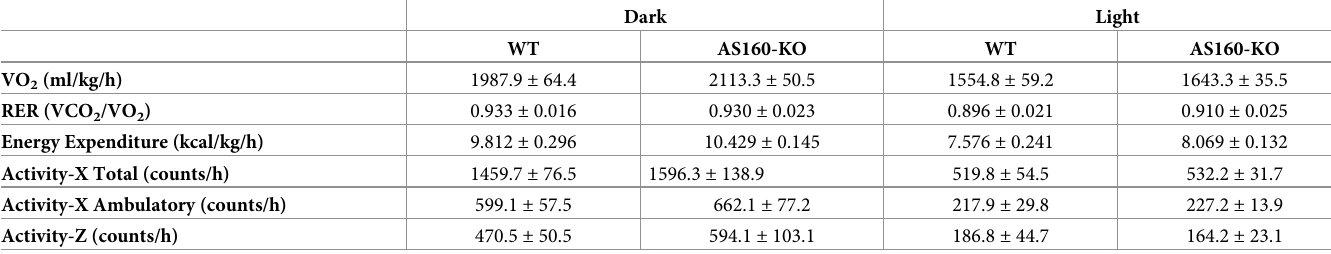
Although 6 WT and 6 AS160-KO rats underwent an HEC, 2 rats from each genotype were not successfully clamped because of technical problems. A catheter placed in one AS160-KO rat failed during the HEC, and the coefficient of variation (CV) for glycemia exceeded 20% for three rats (WT, n = 2; AS160-KO n = 1). Accordingly, the data from these 4 rats were not included in the statistical analysis of parameters dependent on blood glucose or insulin (Table 4), tissue glucose uptake and phosphorylated insulin signaling proteins. The CV for the remaining 4 WT rats (3–14%) was comparable to the CV for the remaining 4 AS160-KO rats (5–12%), and the reported values for blood or plasma parameters, tissue glucose uptake, and phosphorylated signaling proteins from the HEC experiment represent the data collected from these 8 animals. Because the total abundance of proteins (AS160, TBC1D1, GLUT4, GLUT1 and hexokinase II) would not be responsive to brief changes in glucose or insulin levels, these values are expressed for all of the rats undergoing the HEC (n = 6 of each genotype). No Table 3. Indirect calorimetry and physical